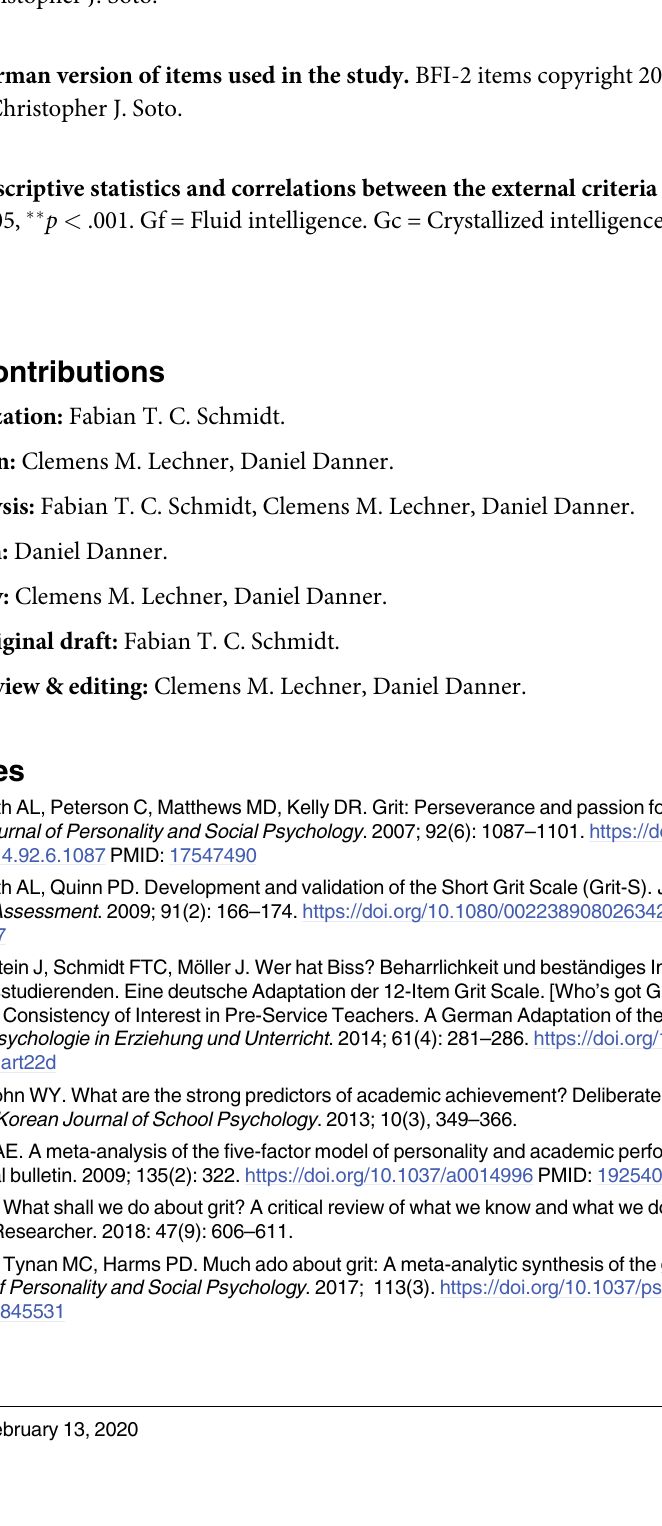
S1 Table. English version of items used in the study. BFI-2 items copyright 2016 by Oliver P. John and Christopher J. Soto. S2 Table. German version of items used in the study. BFI-2 items copyright 2016 by Oliver